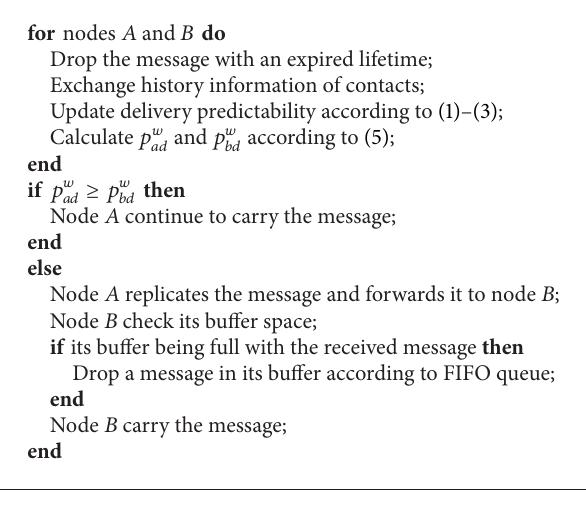
Algorithm 1: The message transmission when node 𝐴 with a message for the destination 𝐷 encounters node 𝐵